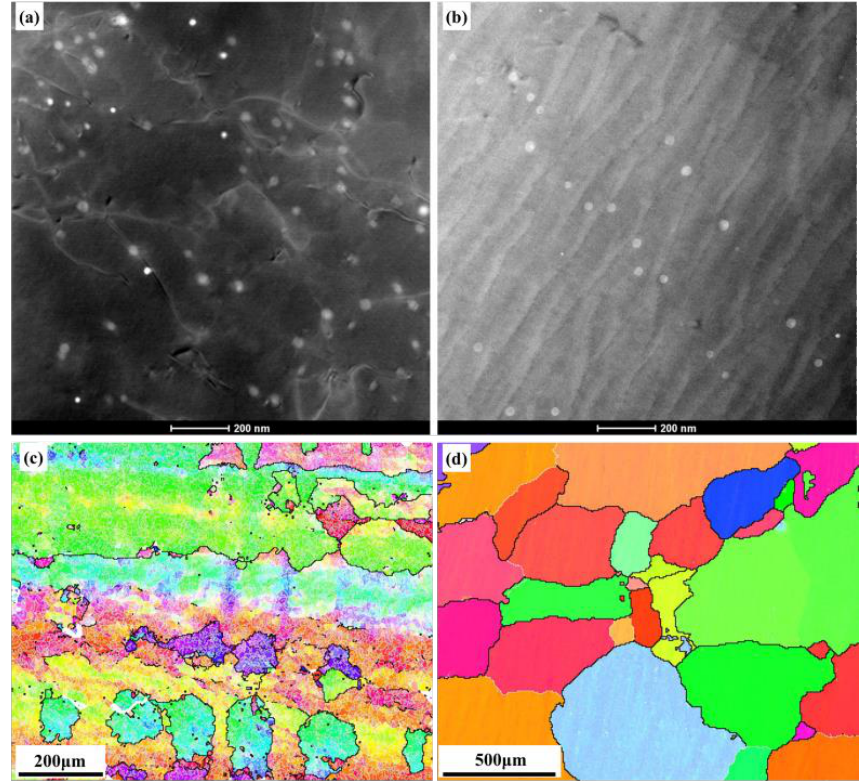
Figure 1. The initial microstructures of 2195 alloy before deformation: ( a , b ) O-state and W-state STEM images, respectively; ( c , d ) O-state and W-state EBSD maps, respectively.